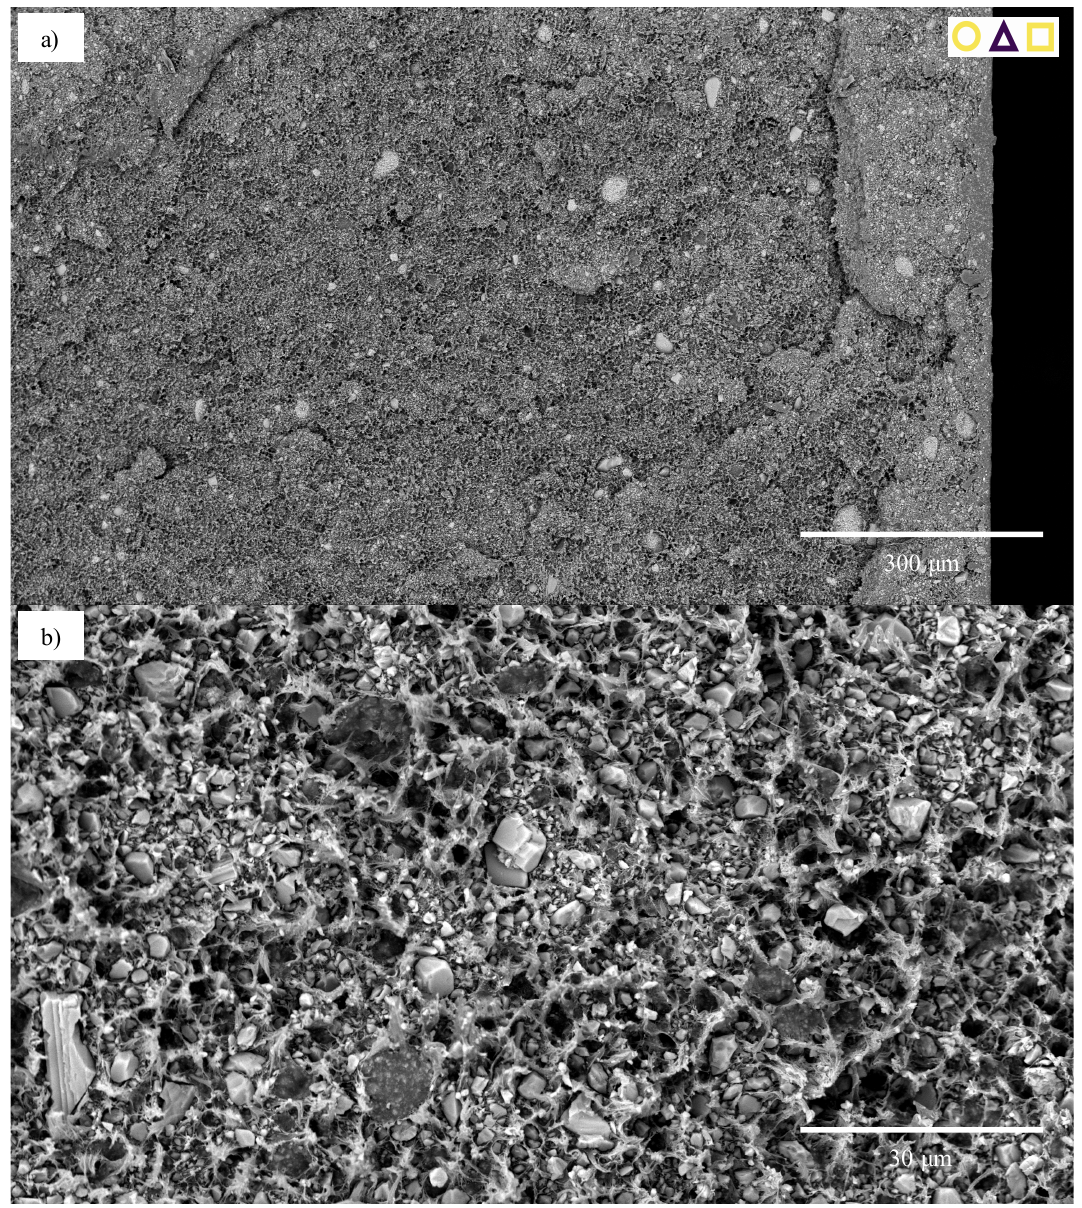
Figure 25. SEM micrographs of the failure regions of a 0-CB/60-CC/0-SP WL specimen: ( a ) general morphology showing dramatically reduced fibrillation and some changes in mechanism moving away from the perimeter; ( b ) detail of fibrillation and particle effects, with debonding and further-reduced fibrillar